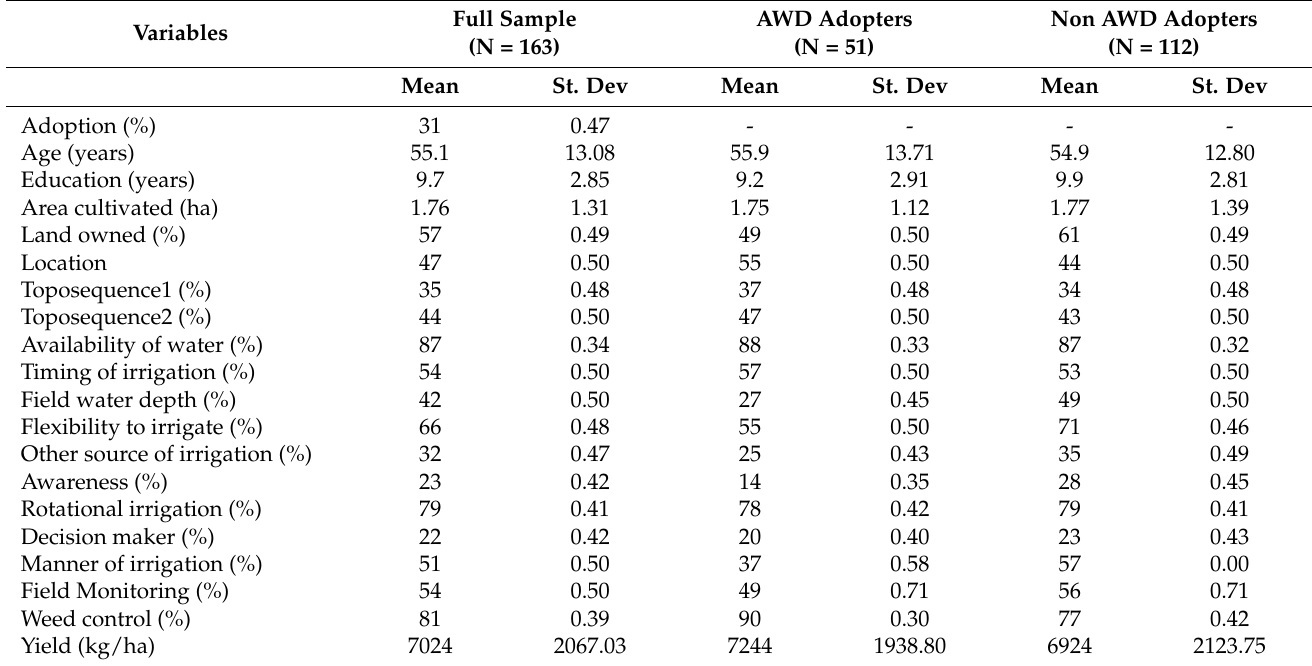
Table 3. Descriptive statistics of sampled population.